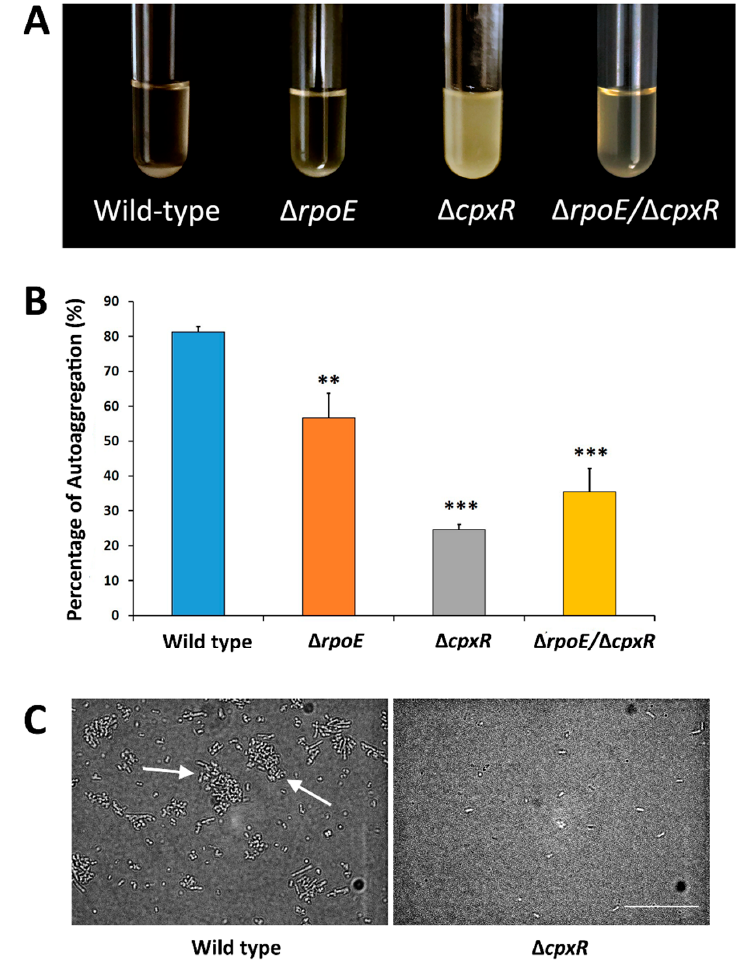
Figure 3. E ff ect of deletion of the rpoE, cpxR and rpoE / cpxR genes on the auto-aggregation. (A ) The ∆ cpxR cells remained in suspension, while the wild-type cells auto-aggregated and settled to the bottom of the tubes. The other two mutants, the ∆ rpoE and ∆ rpoE / cpxR, showed intermediate auto-aggregation phenotypes compared to the wild-type and ∆ cpxR mutant. ( B ) Quantitative measurements of sedimentation-based auto-aggregation assay of the wild-type and mutant strains. Each data point represents the average of at least three independent experiments. The error bars represent the standard deviation determined by t-test on comparison with wild-type. ** p < 0.01, *** p < 0.001. ( C ) Digital microscope photographs of the wild-type and ∆ cpxR cells from the auto-aggregation assay, as obtained using phase contrast microscopy and a digital camera. Arrows depicts cell aggregates. Scale bar indicates 20 µm.